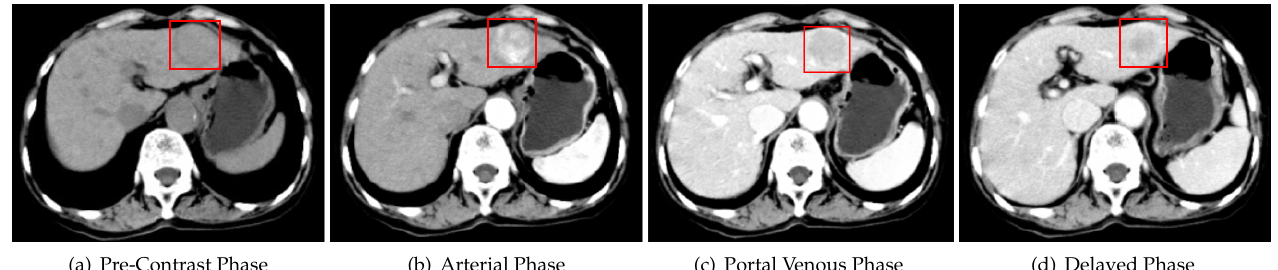
Figure 1. Four-phase image of CT images. Lesion area is labeled by the red box: ( a ) shows the pre-contrast phase image without injecting intravenous contrast media; ( b ) shows the lesion areas tend to enhance more strongly than background liver during late arterial phase imaging (APHE); ( c ) shows the liver continues to enhance, and the lack of portal venous blood supply to HCCs results in the characteristic washout in the portal venous phase (WO); ( d ) shows the hypodense appearance of HCC in the delayed phases